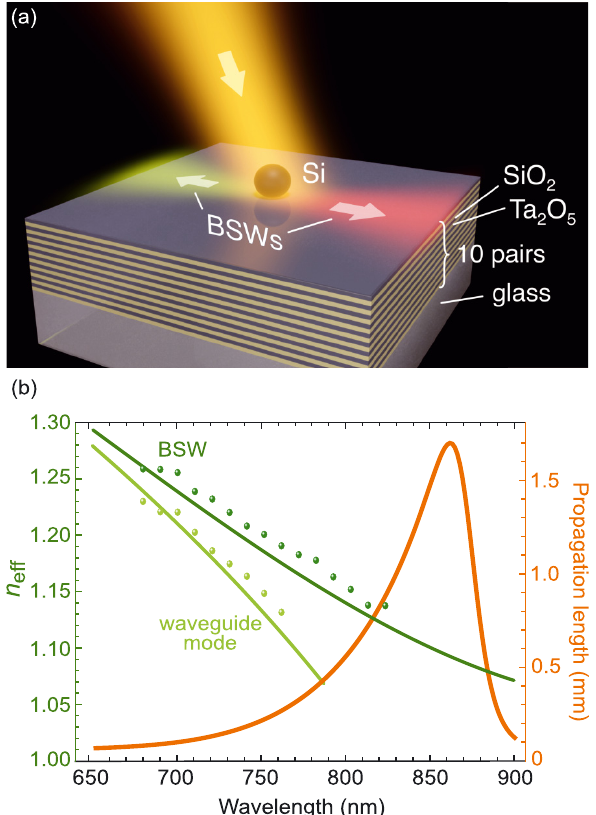
Figure 1: (a) Sketch of the idea: Color-selective excitation of Bloch surface waves (BSWs) as a result of directional light scattering at a Mie-resonant silicon nanoparticle. (b) Spectral dependences, measured (green dots) and calculated (green curves), of the for BSWs (dark green colors) and effective refractive index n eff waveguide mode (light green colors), and BSW propagation length (orange